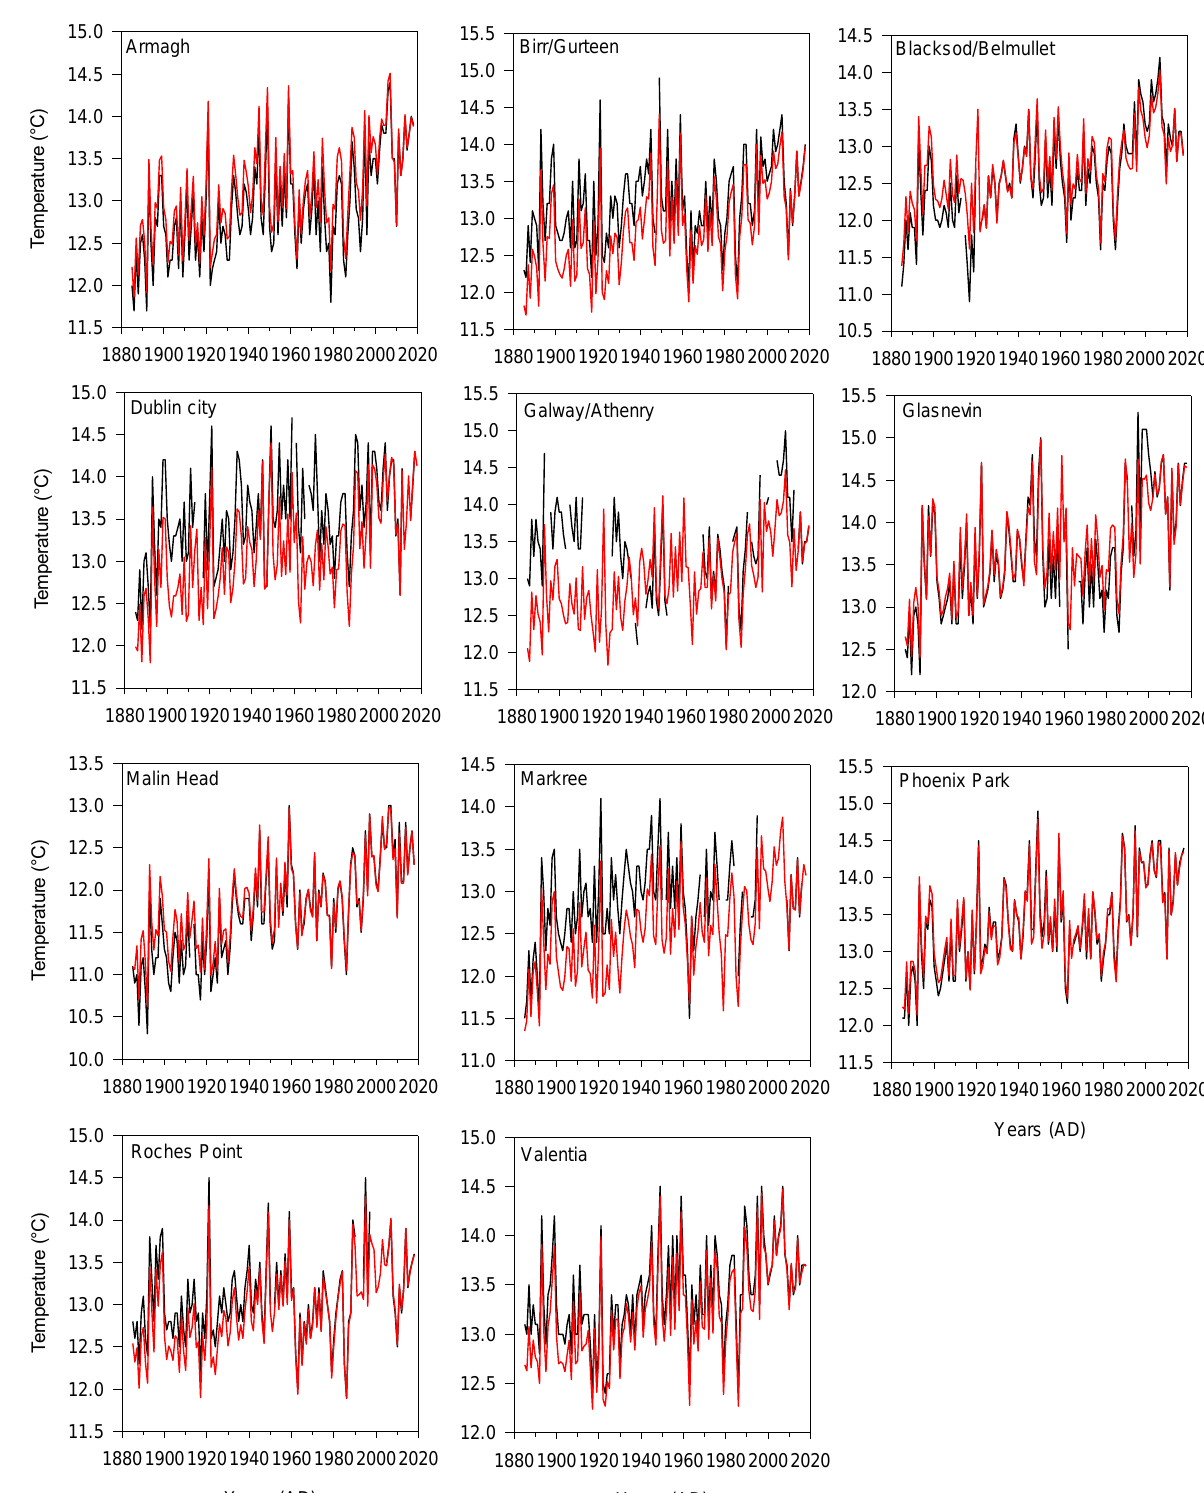
Figure 4. Quality-controlled (black) and homogenised (red) annual MAX series as part of the national network in 1885 – 2018.